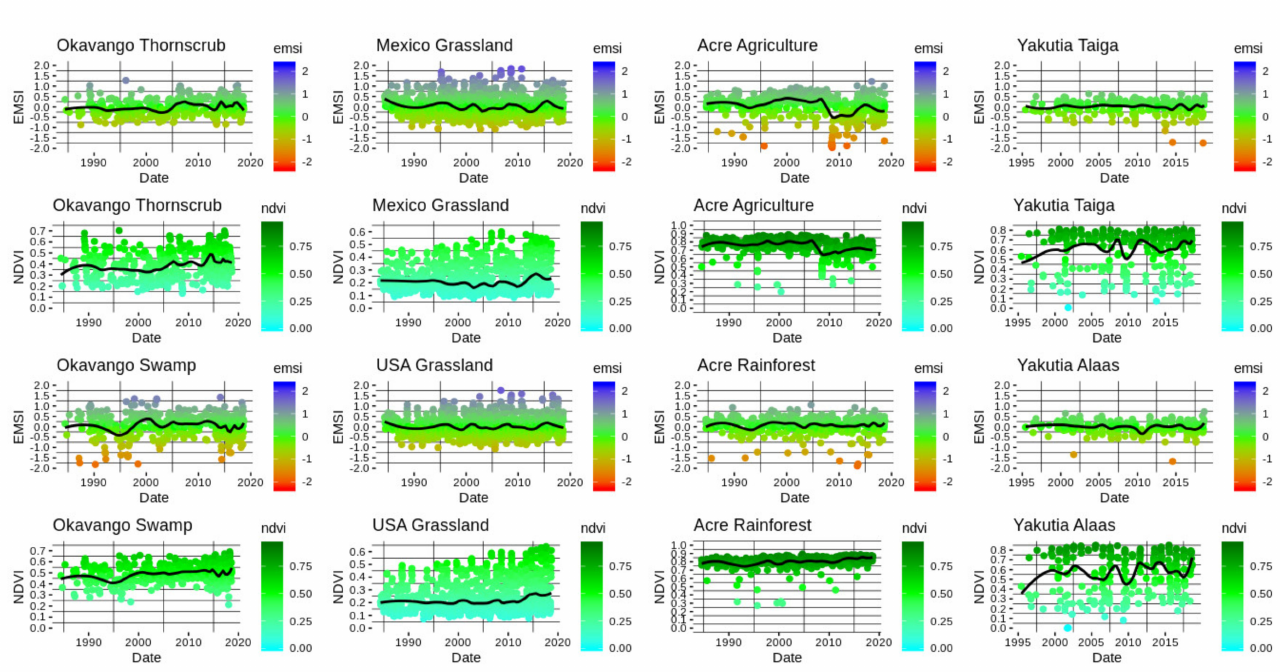
Figure A2. NDVI and EMSI Time series for the Landsat 5, 7, and 8 series at all eight study sites. The black line is the long-term moving average over